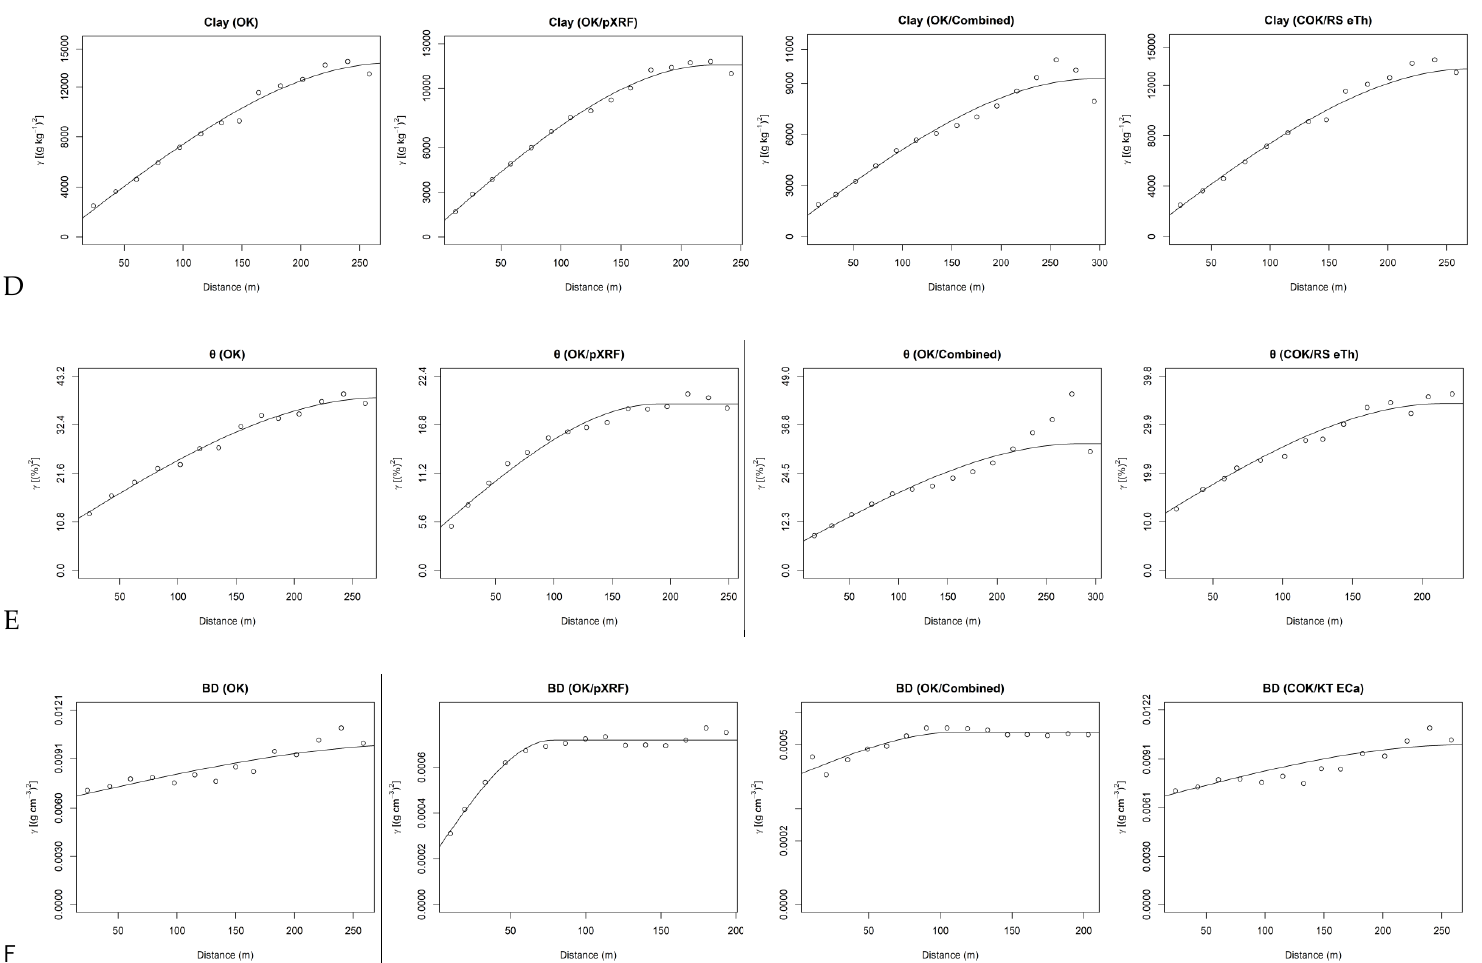
Figure 3. Empirical and fitted spherical variograms of soil ( A ) organic carbon content (OC; g kg − 1 ), ( B ) sum of bases (SB; cmol c kg − 1 ), ( C ) cation exchange capacity (CEC; cmol c kg − 1 ), ( D ) clay content (g kg − 1 ), ( E ) volumetric moisture ( θ ; %), and ( F ) bulk density (BD; g cm − 3 ). OK, ordinary kriging; COK, ordinary cokriging; eTh, equivalent Th content; ECa, apparent electrical conductivity; pXRF, DP-6000 portable X-ray fluorescence spectrometer; RS, RS-230 BGO gamma-ray spectrometer; KT, KT-10 S / c MSa / ECa